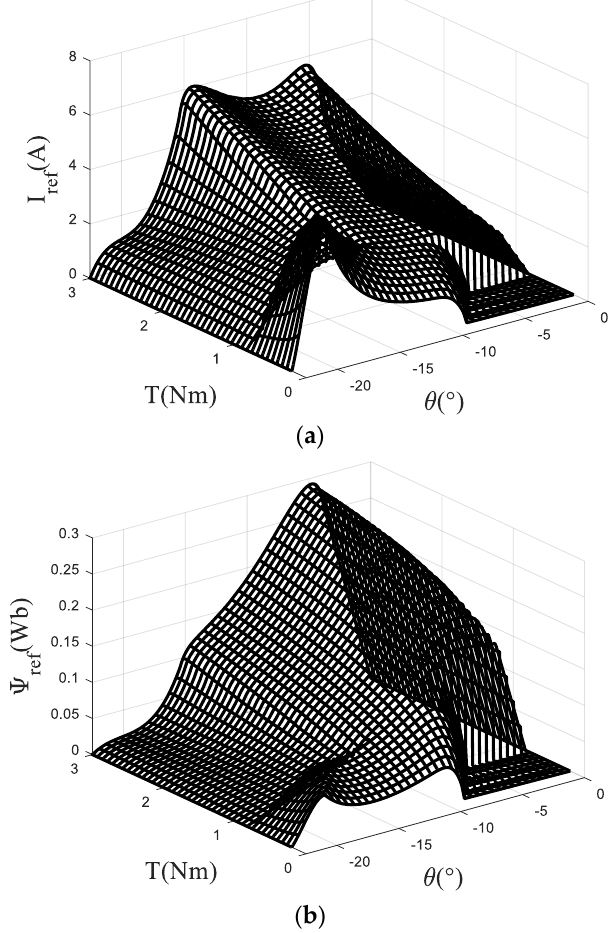
Figure 8. Reference current and flux linkage under 1000 rpm ( a ) current ( b ) flux linkage.